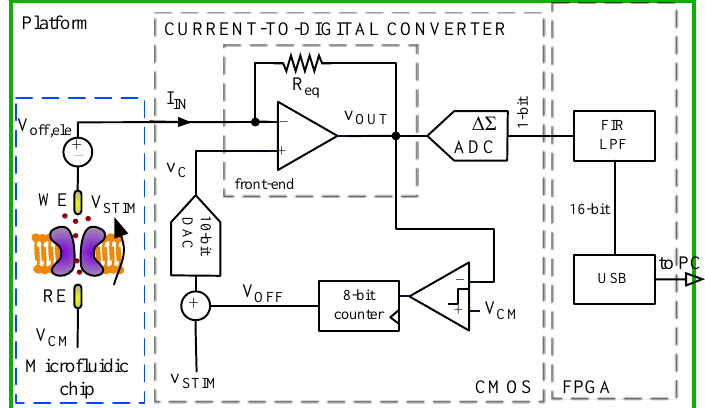
Figure 3. Block diagram of the system. A lipid bilayer is formed in a microfluidic chip, with integrated Ag/AgCl electrodes. Reference Electrode (RE) is tight to V CM while working electrode (WE) is connected to the input of the transimpedance amplifier. The CMOS transimpedance amplifier acquires the input current i IN and digitizes it into a 1-bit high-frequency delta-sigma modulated stream. It also compensates for electrode and opamp offset by means of a digital compensation loop that is activated at the beginning of every experiment. The ADC output is filtered and decimated by a digital FIR filter implemented on a FPGA. Data communication with PC is via a USB link. Virtual short circuit realized by the input LNA is used to apply a stimulus voltage v STIM to the